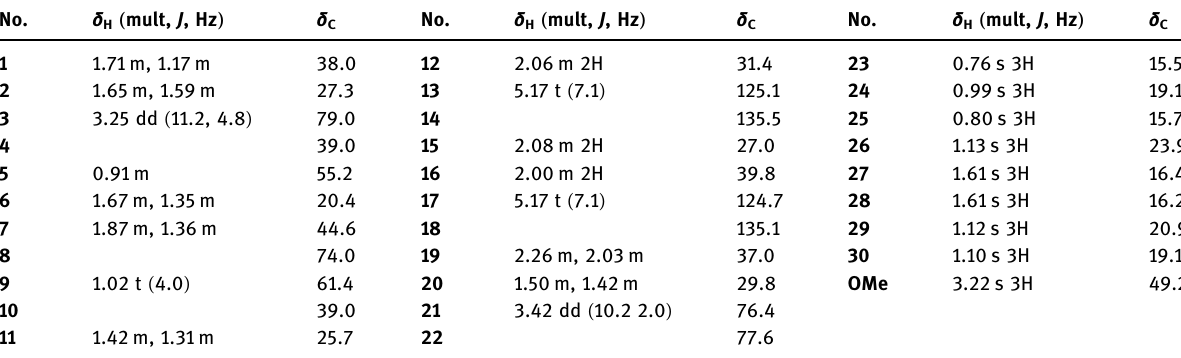
Table 1: 1 H NMR ( 400 MHz ) and 13 C NMR ( 100 MHz ) data of 1 ( in CDCl 3 )